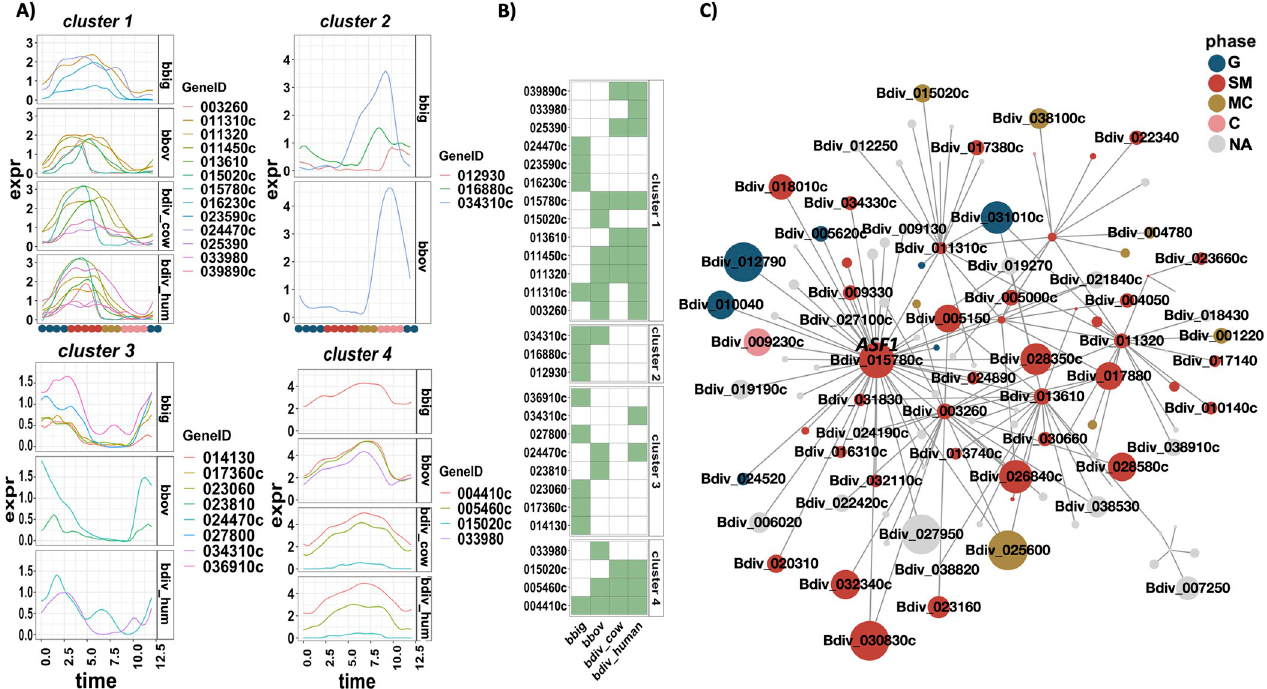
Fig 8. Expression profile of epigenetic markers with a cyclic pattern of expression. (A) The expression curves of epigenetic marker genes clustered into 4 groups according to their expression similarity, split by species. (B) Presence AU : InthelegendtoFig 8 : Pleasecheckthattheeditstothesentence } ð B Þ Presence ::: } captureyourmeaning : Ifnot ; pleaseprovidecorrectwording : (green) or absence (white) of the gene (rows) in the indicated sample (column); absence indicates that the gene is either not cyclically expressed or belongs to a different cluster (033980, 024470c, 015020c, and 034310c). (C) Interaction co- expression network of epigenetic marker genes in B . divergens (human) in cluster 1 (9 total). Data and code for generating the figure are available at https://